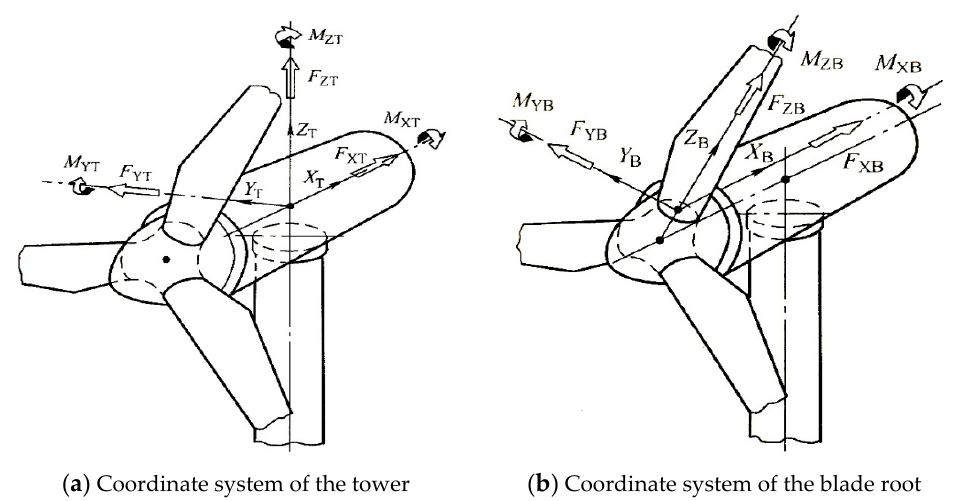
Figure 7. Coordinate systems for wind turbine loads analysis.